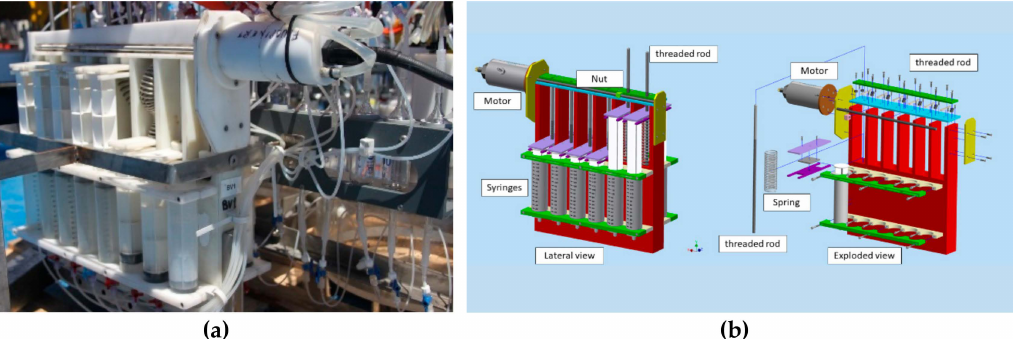
Figure 11. The VAMPIRE device allows drawing water into the chamber or expelling it as well as injecting a tracer inside the chamber. ( a ) Photograph of the VAMPIRE device installed on the Amerigo Lander; ( b ) schematic drawing of the VAMPIRE device.